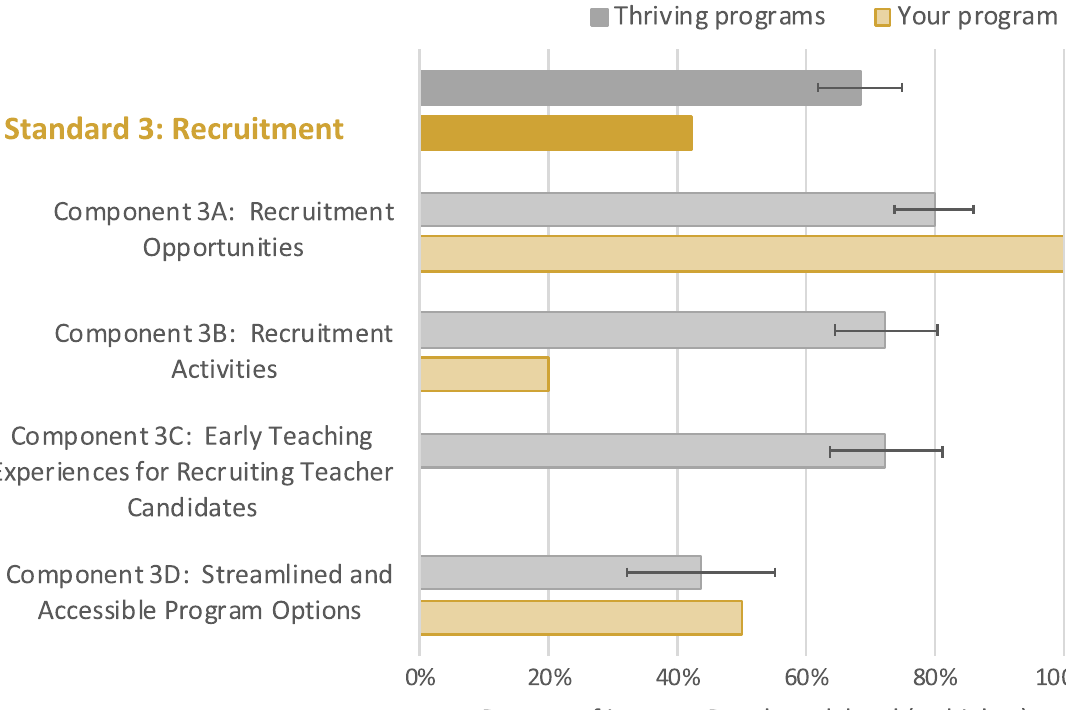
FIG. 2. Sample institutional data for the PTEPA rubric for standard 3 for a fictitious program, compared to the actual data for the 8 thriving programs. Percentages represent the percent of items rated at benchmark or exemplary level. Thriving program data represent the percentage at least benchmark, averaged across the items in that component and across the 8 thriving programs. Error bars represent the standard error of the